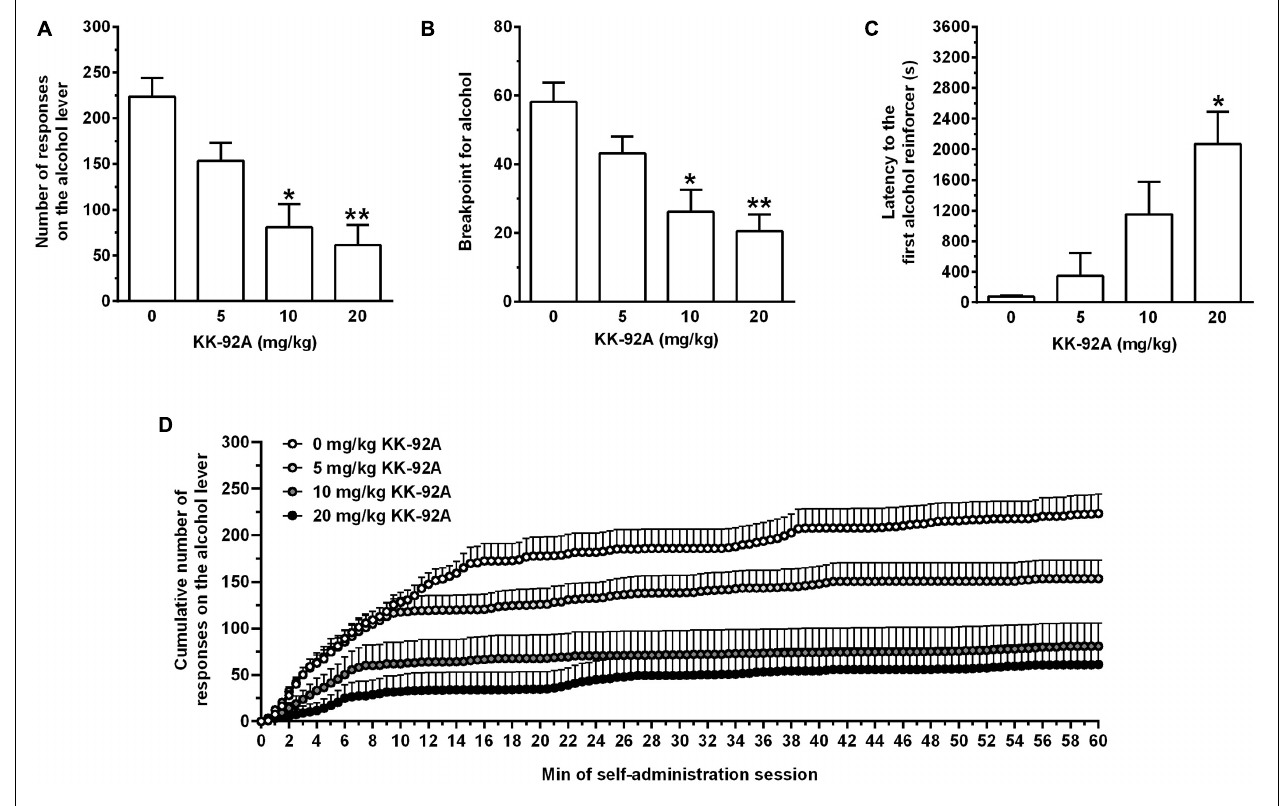
FIGURE 4 | Effect of acute treatment with the positive allosteric modulator of the GABA B receptor, KK-92A, on number of lever-responses for alcohol (A) , breakpoint for alcohol (B) , latency to the first response on the alcohol lever (C) , and cumulative response patterns of alcohol self-administration (D) in female Sardinian alcohol-preferring rats. Rats were initially trained to lever-respond for oral alcohol (15% v/v, in water) [Fixed Ratio (FR) 5 (FR5)] and water (FR1) in daily 30-min self-administration sessions. Once lever-responding had stabilized, rats were tested with KK-92A under a progressive ratio schedule of reinforcement, in which the response requirement (RR) was increased progressively over a 60-min session. Breakpoint was defined as the lowest RR not achieved by the rat. KK-92A was administered intraperitoneally 30 min before the start of the self-administration session. In panel (D) , the self-administration session was divided into 60 intervals of 1 min each. Each bar or point is the mean ± SEM of n = 12 rats. * P < 0.001 and ** P < 0.0001 in comparison to the rat group treated with 0 mg/kg KK-92A (Tukey’s